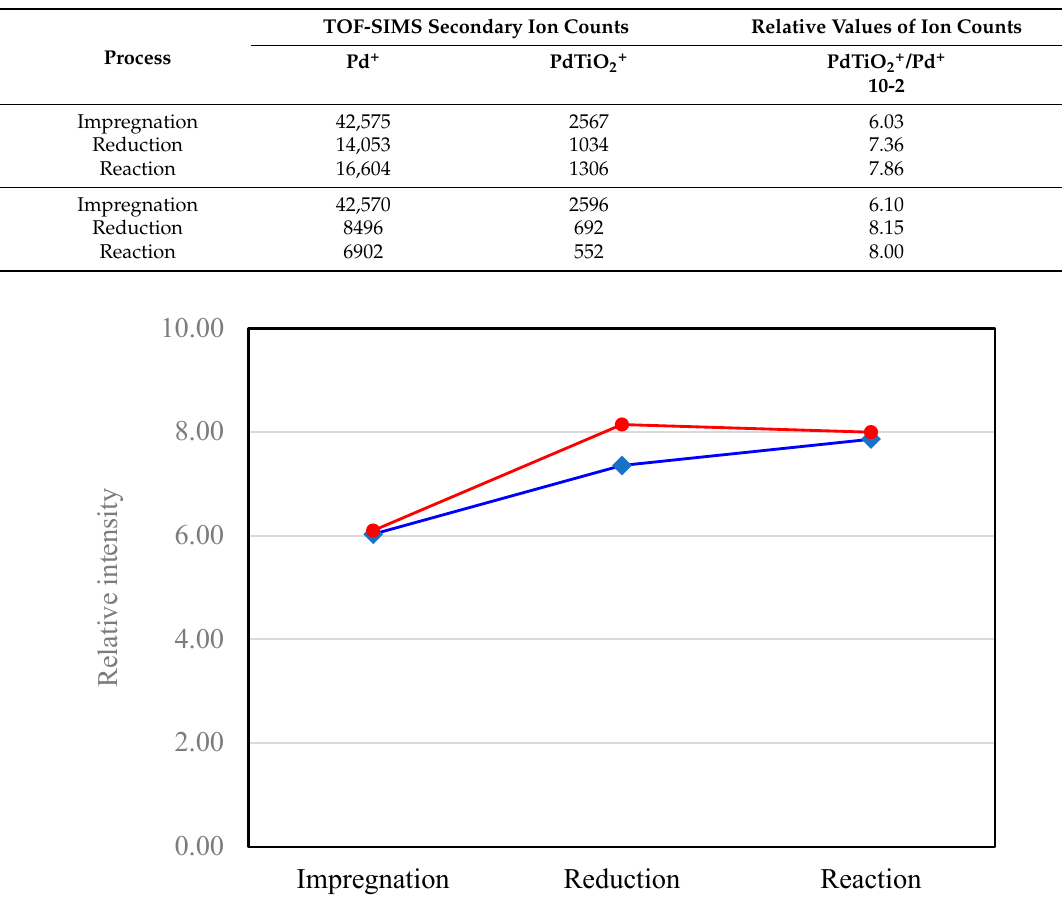
Figure 10. TOF–SIMS spectrum of the 2.5%Zn–5%Pd/TiO 2 catalyst after impregnation (a), reduction (b), and reaction (c); * peaks assigned to PdTiO 2+ ions in ToF-SIMS spectra. Table 4. Secondary ion counts for 5%Pd/TiO 2 and 2.5%Zn-5%Pd/TiO 2 catalysts.